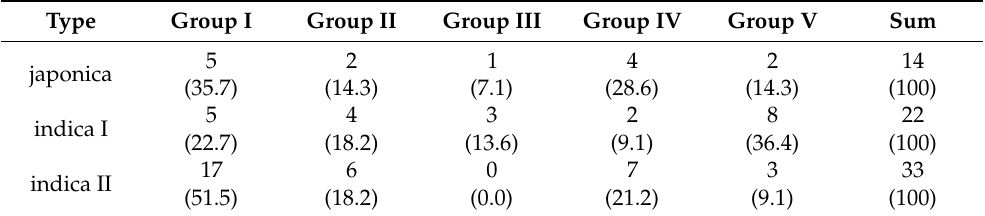
Figure 6. Germination ‐ inducing activity (pre ‐ attachment resistance) and percentage of successful parasitism (post ‐ attachment resistance) of each accession in five groups. Table 1. Number and proportion of accessions allocated to each group within japonica, indica I, and indica II type.